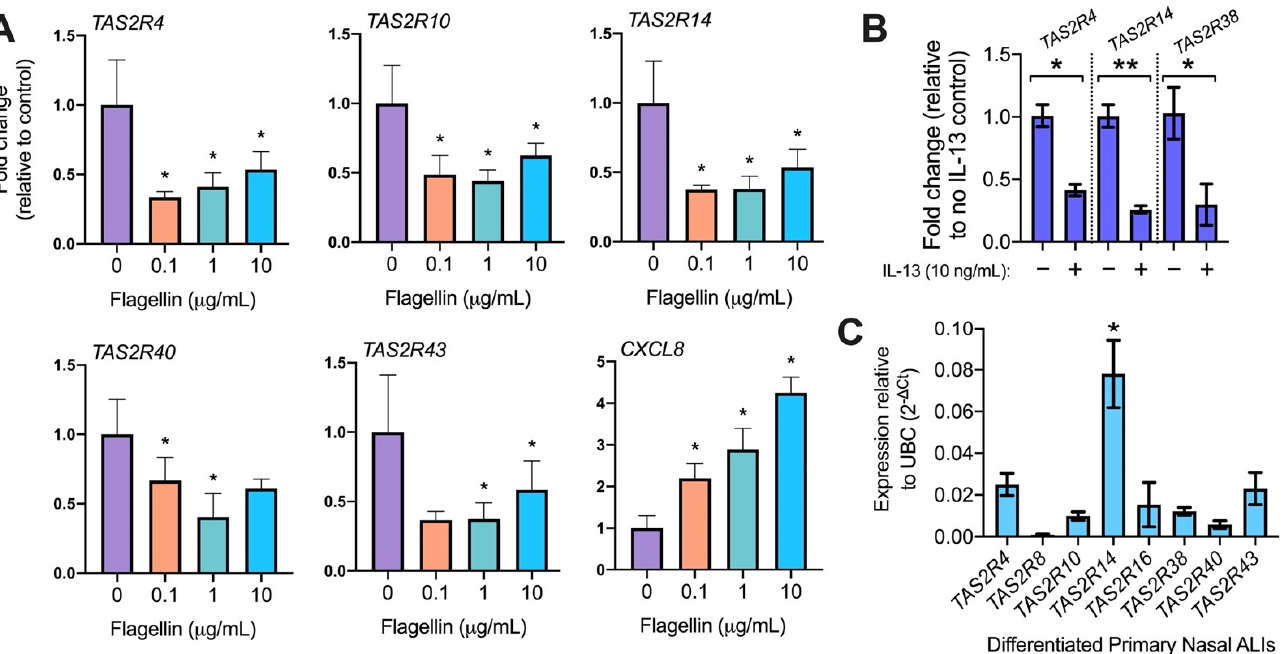
Figure 3. Changes in T2R expression with inflammatory mediators. ( A ) Flagellin decreases T2R expression in nasal ALIs. Human nasal epithelial cells were isolated and grown in ALI cultures and then exposed to air to induce differentiation for 4 weeks prior to treatment. Cultures were treated with various concentrations of flagellin (0.1, 1 or 10 µg/mL) for 24 h prior to RNA analysis via qPCR. Bar graphs represent combined data from 4 patients. Data were analyzed by one-way ANOVA, Dunnett’s post-test; * p < 0.05. ( B ) IL-13 treatment decreases T2R expression in nasal ALIs. Human nasal epithelial cells were isolated and grown in ALI cultures then exposed to air to induce differentiation for 3 weeks prior to treatment. Data were analyzed by one-way ANOVA, Bonferroni post-test; * p < 0.05 and ** p < 0.01. Bar graph represents combined data from 4 patients. ( C ) Expression of T2Rs in 3-week post-air primary nasal ALIs normalized to housekeeping gene UBC using 2 - Δ Ct method where Δ Ct = Ct GAPDH – Ct target gene . Data shown are the mean ± SEM from ALIs grown from 15 different individual patients. TAS2R14 expression was significantly higher than other TAS2R genes examined by one-way ANOVA with Bonferroni post-test; * p < 0.05.